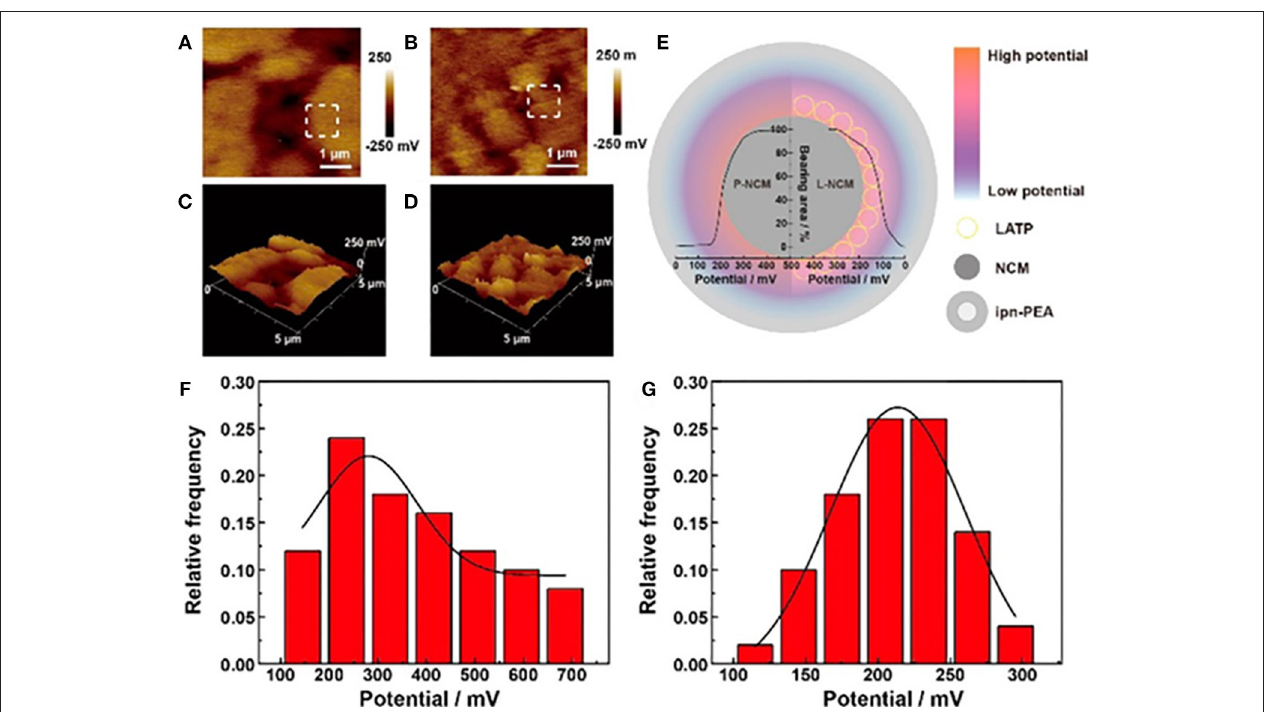
FIGURE 8 | AFM interfacial potential images and the corresponding 3D images of (A,C) pristine-NCM and (B,D) LATP coated-NCM. (E) Schematic diagram with bearing analysis and potential distribution of the two cathodes. The Gauss statistic distribution histograms of interfacial potential for (F) pristine-NCM and (G) LATP coated-NCM. [Reprinted with permission from ( Liang et al., 2018). Copyright (2018) American Chemical